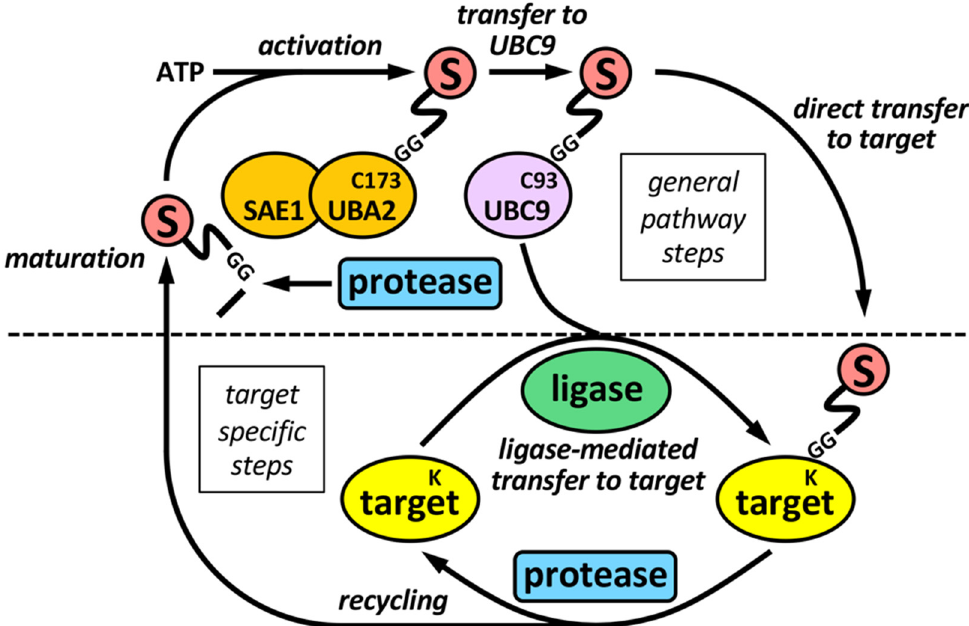
Figure 1. The sumoylation pathway. E1 enzyme (SAE1-UBA2 heterodimer), by using ATP, activates mature SUMO and transfers it to the E2 enzyme UBC9, which ultimately transfer SUMO to targets, either directly, or more frequently, assisted by an E3 SUMO ligase. SUMO maturation and scission from targets are performed by specific SUMO proteases. Maturation involves the exposition of two tandem Gly (G) residues at the C-terminus of mature SUMO. Activation and transfer to UBC9 involve the formation of thioester bonds between C-terminus of mature SUMO and specific Cys (C) residues at catalytic sites of E1 and E2, respectively. Defined Lys (K) residues at targets are the final SUMO acceptors for covalent attachment. Proteases and ligases are linked to target selection-associated steps in the sumoylation pathway.